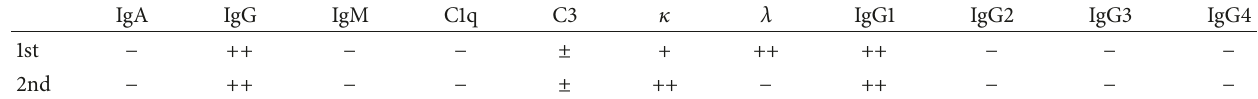
Table 1: The immunofluorescent findings of 1st and 2nd kidney